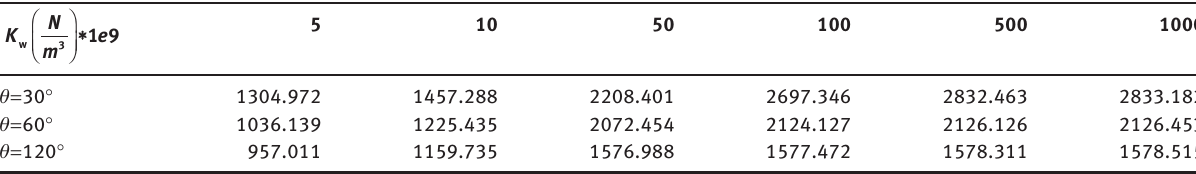
Table 6 Fundamental natural frequencies of a fully clamped orthotropic FG annular sector plate for different Winkler parameters and sector angles (n = 0.1).